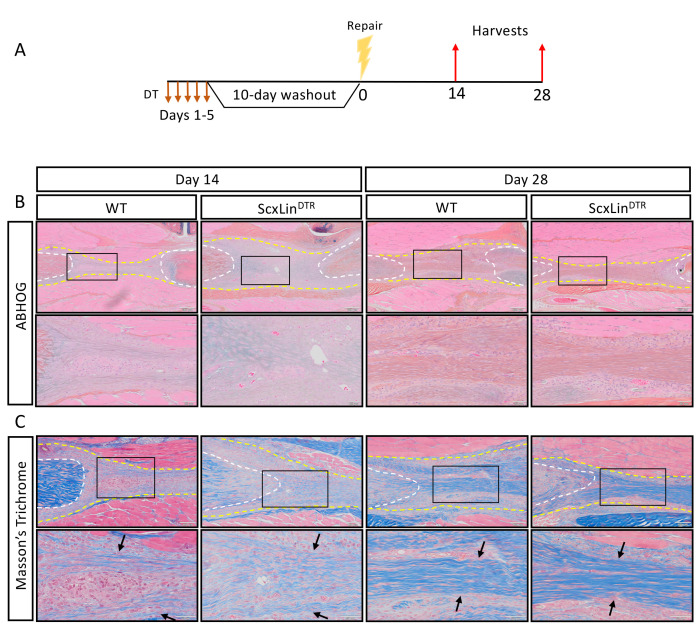
ScxLin cell depletion does not disrupt formation of a bridging collagen matrix.Mice received five hindpaw injections of DT on consecutive days, underwent flexor tendon repair surgery 10 days after the final DT injection, and were harvested at 14 and 28 days post-repair (A). Alcian blue/hematoxylin and Orange G stain utilized to assess overall morphology (B). Masson’s trichrome stain used to visualize collagen content and organization (C). Tendon is outlined by white dotted line and scar tissue by yellow dotted line. Black boxes indicate location of higher magnification images. Boundaries of bridging collagen indicated by black arrows. N = 4 genotype per timepoint. Suture indicated by *.